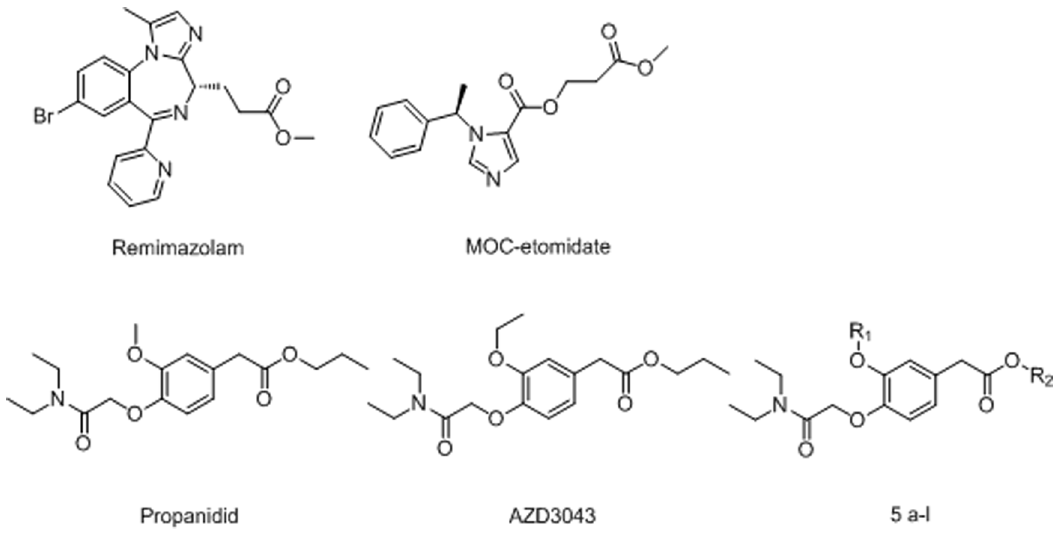
Figure 1. Title and reference compounds.